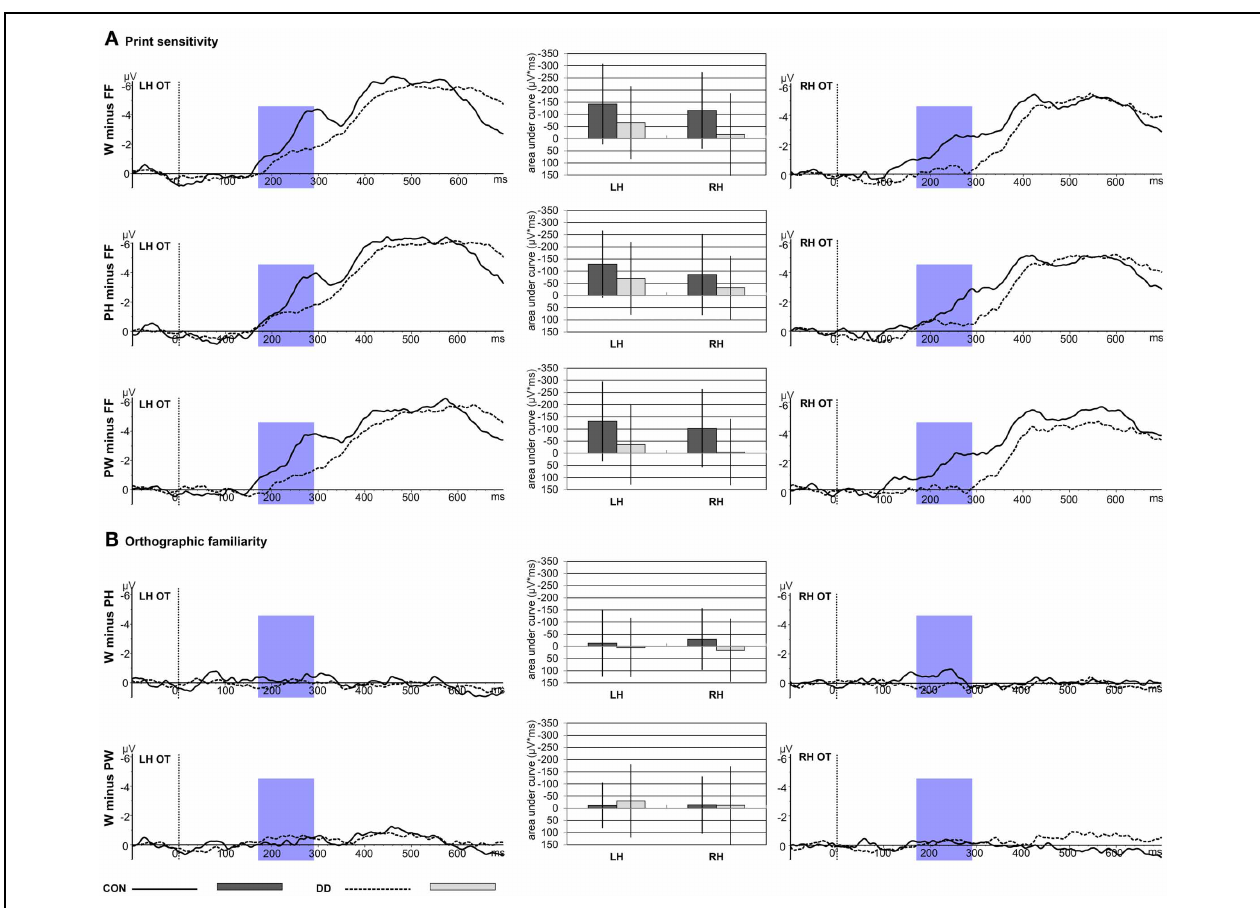
FIGURE 4 | Print sensitivity and orthographic familiarity for control children (CON) and children with DD (DD). The time window selected for the N170 difference waves is highlighted in blue (170–290 ms). W, words; PH, pseudohomophones; PW, pseudowords; FF, false fonts; OT, average across occipito-temporal electrodes included in the left hemispheric (LH) and right hemispheric (RH) ROIs of the N170 difference waves. Negativity is depicted upwards. Error bars illustrate standard